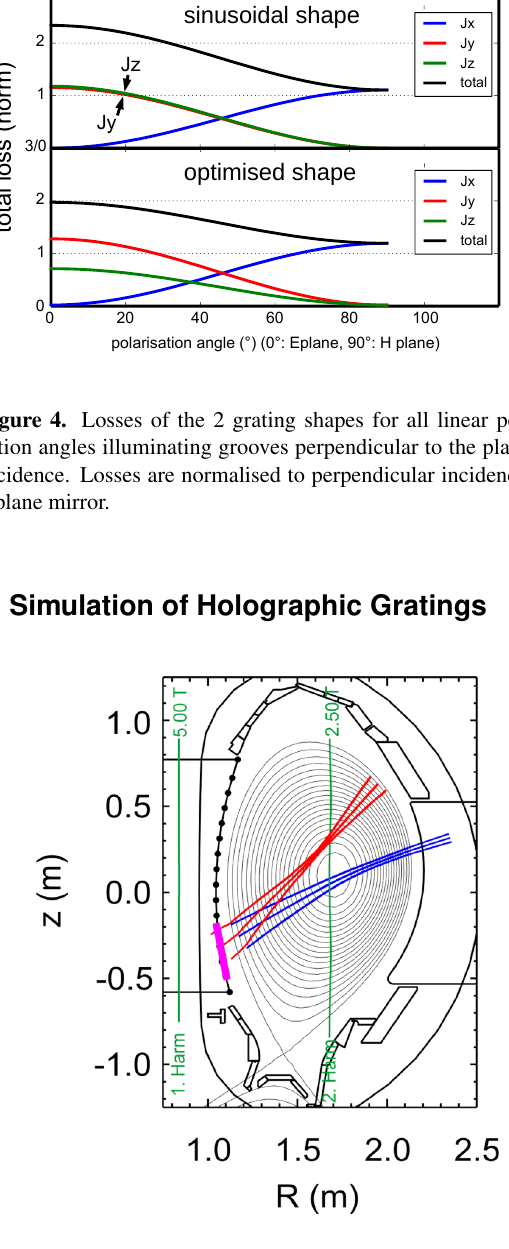
Figure 5. Setup of one of the reflecting tiles for ECRH in AS- DEX Upgrade. The blue beam is coming from the launchers, and the red beam is reflected into the plasma.